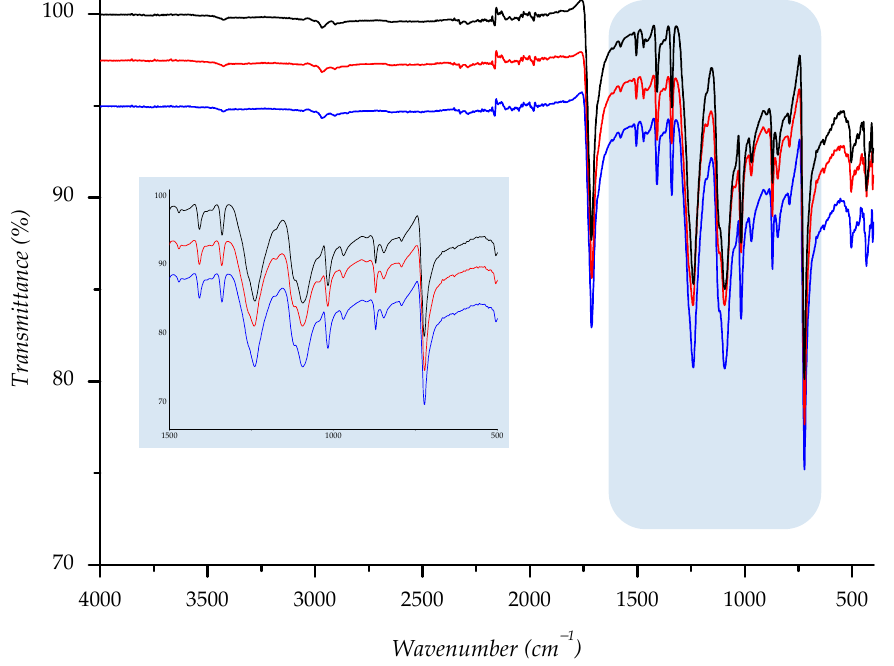
Figure 18. IR spectra of investigated sample F5 ((—) = starting material; (—) = material aged in sun; (—) = material aged in shade) with enlarged fingerprint region (colored in blue).